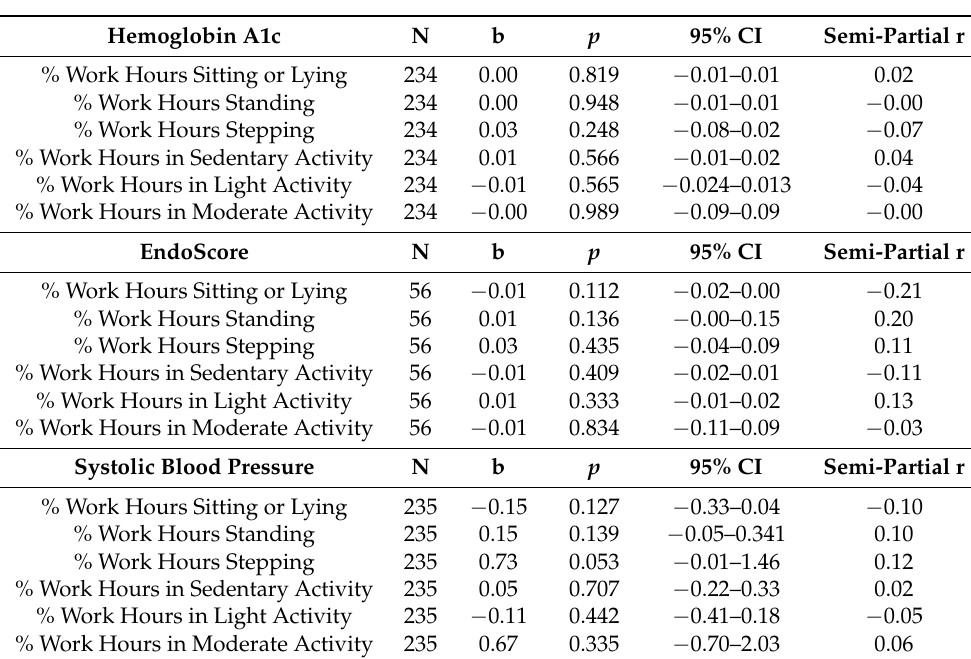
Table 5. Regression Coefficients for Work Activity Variables and Physiological Markers.